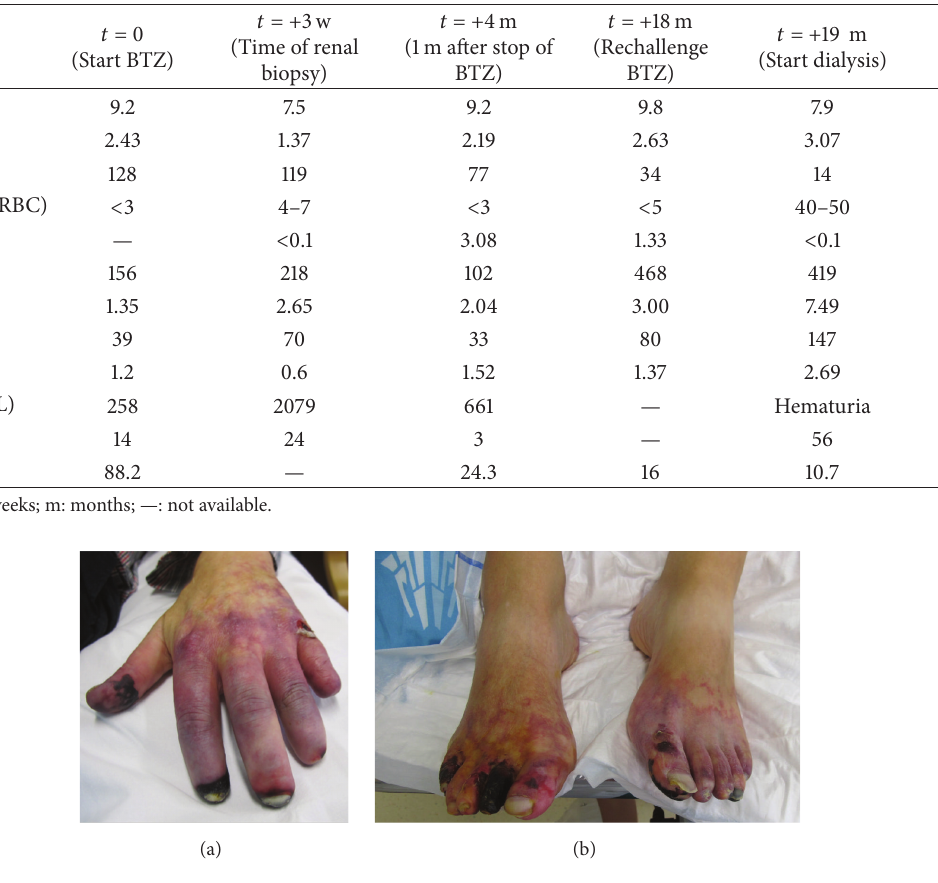
worsened, with development of a livedoid rash and painful edema of hands and feet and multiple necrotising ulcers (see Figure